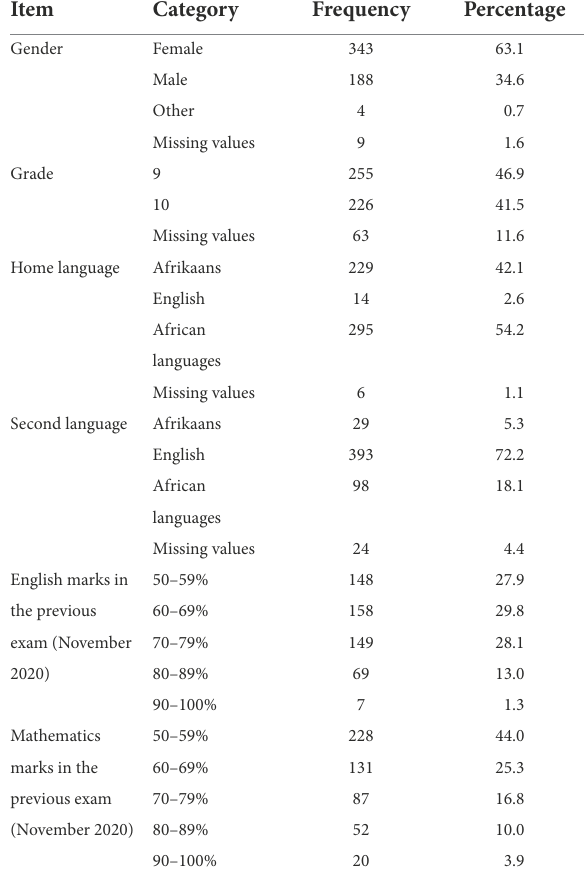
TABLE 1 Characteristics of participants ( N =